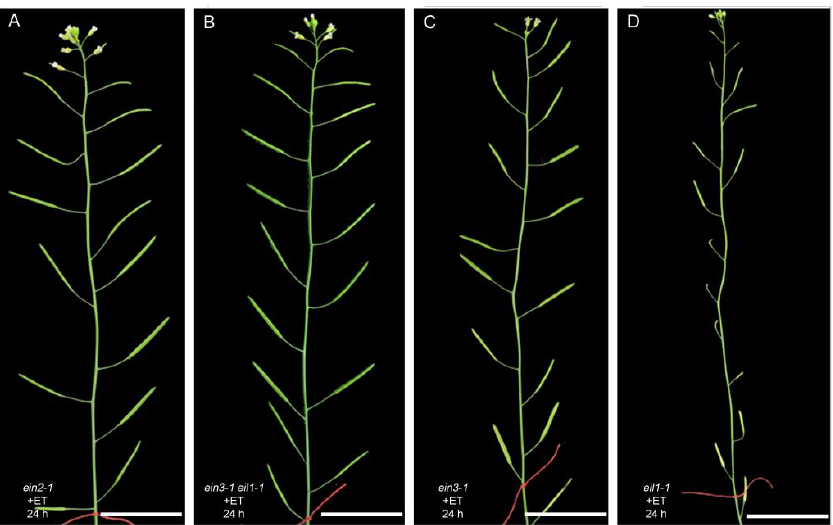
Figure 5. The inflorescence of ein2-1 and ein3-1 eil1-1 is insensitive to exogenous ethylene treatment. ( A – D ) The inflorescence of ein2-1 ( A ), ein3-1eil1-1 ( B ), ein3-1 ( C ) and eil1-1 ( D ) after treated with ethylene (100 µ L L − 1 ) for 24 h. After ethylene treatment, these plants were transferred to normal growth condition for 14 days. Bars = 2 cm.